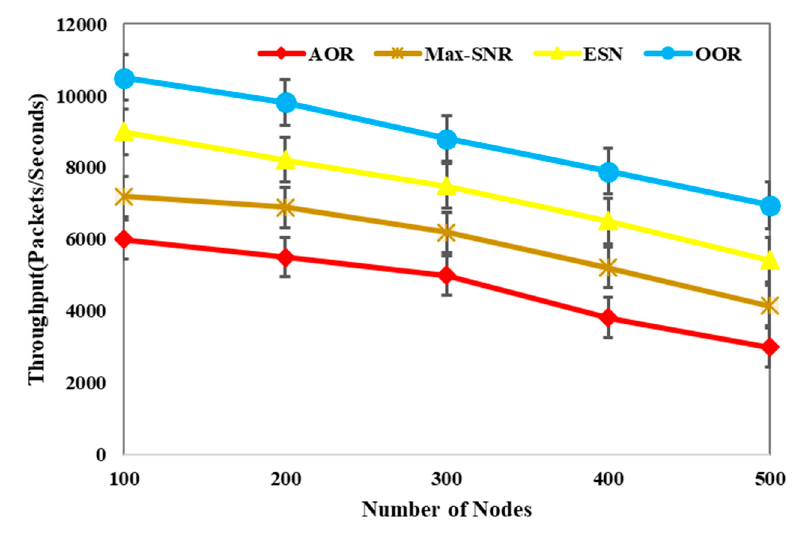
Figure 8. Throughput comparison with varying number of nodes. Table 3. Descriptive observations of OOR performance in terms of throughput.